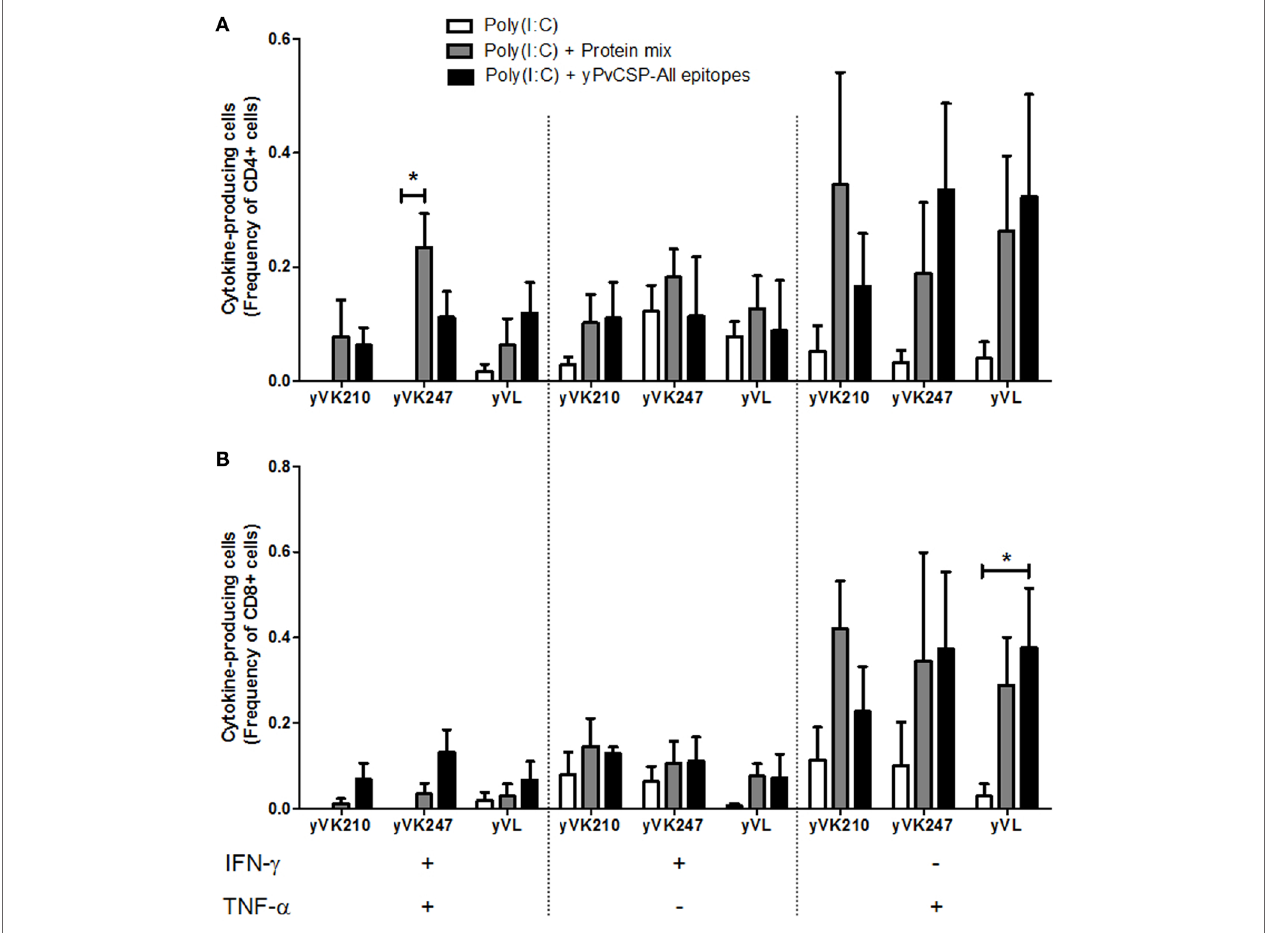
FigUre 7 | CD4 + and CD8 + T cell-mediated immunity of mice immunized with recombinant proteins. C57BL/6 mice were immunized s.c. with the recombinant proteins following the scheme described in Figure 6a . To determine the intracellular expression of interferon gamma (IFN- γ ) and tumor necrosis factor alpha (TNF- α ), intracellular cytokine staining (ICS) was performed following the in vitro culture of splenocytes in the presence or absence of the antigenic stimuli yPvCSP- VK210 (yVK210), yPvCSP-VK247 (yVK247), and yPvCSP- P. vivax -like (yVL). (a) Frequency of CD4 + cytokine-producing cells. (B) Frequency of CD8 + cytokine- producing cells. Asterisks denote statistically significant ( P < 0.05) higher frequencies of cells from mice immunized with the recombinant proteins when compared to cells from mice injected with adjuvant only. Media backgrounds of all samples were subtracted before